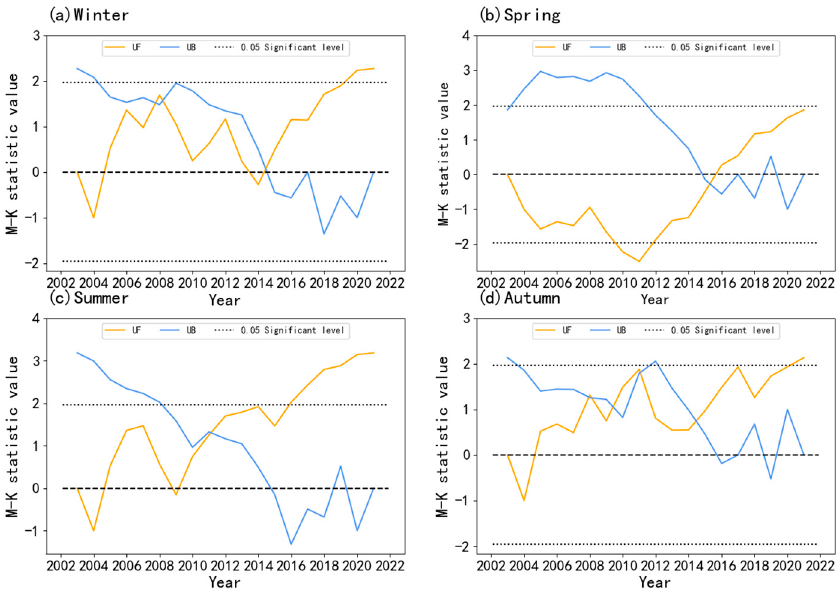
Figure 6. Mann-Kendall statistic curve of TCWV in seasonal in China. ( a ) Winter. ( b ) Spring. ( c ) Summer. ( d ) Autumn.